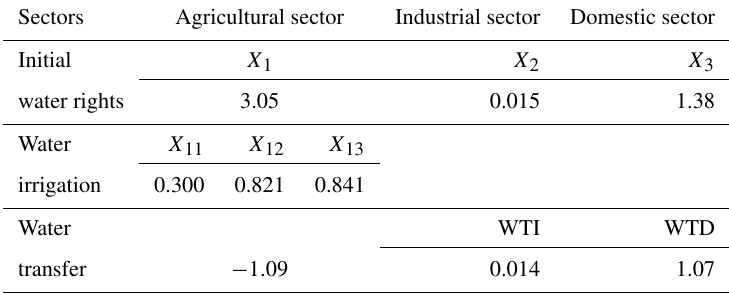
Table 3. Optimal water withdrawal results (10 9 m 3 ).